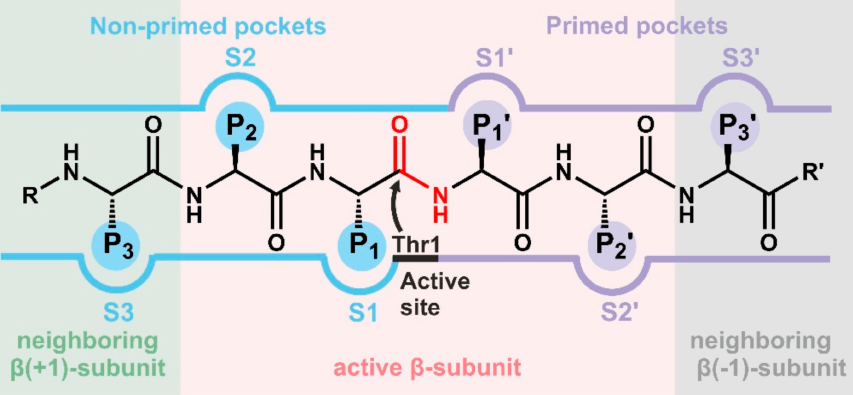
Figure 2. Schematic illustration of the proteasomal substrate binding channel with non-primed (S) and primed (S’) specificity pockets interacting with the amino acid side chains (P-sites) of a peptide. The proteolytically active β -subunit features the active site Thr1 and all other catalytic residues, while the neighboring β -subunits contribute specificity pockets only to the substrate binding channel and do not necessarily feature their own active